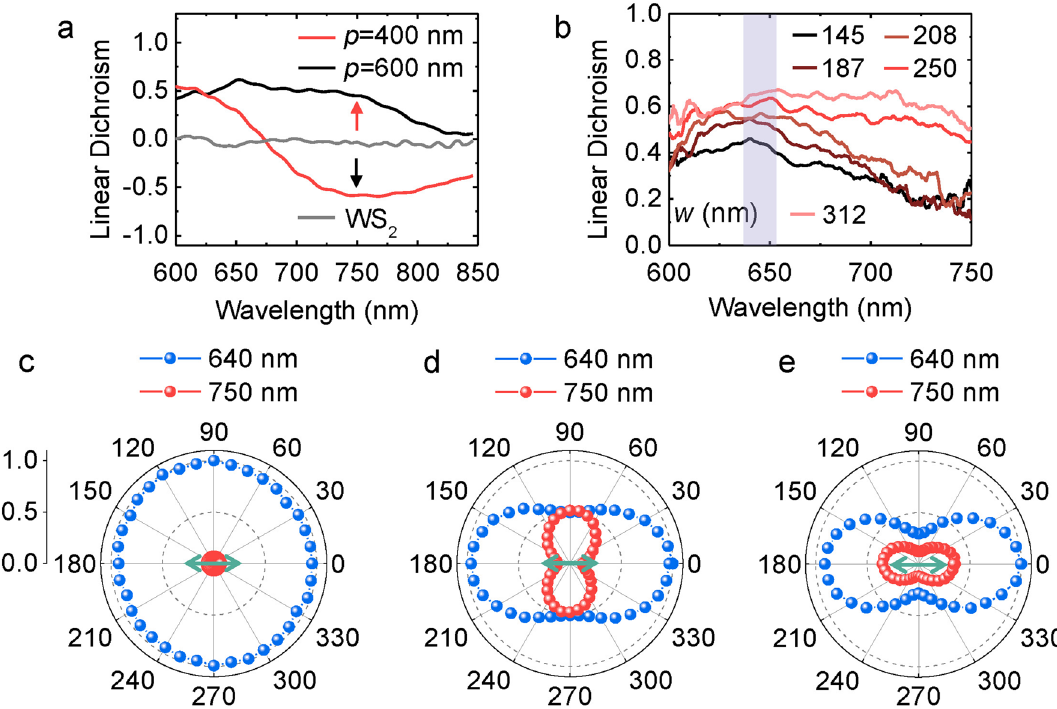
Figure 6. Linearity of the direct and indirect bandgap transitions modulated by the plasmonic nanowire array. ( a ) Linear dichroism of the PL emission for pristine bilayer WS 2 (grey curve) and WS 2 -Ag hybrid nanostructures with p = 400 (red curve) and 600 nm (black curve) respectively. ( b ) Linear dichroism of WS 2 -Ag hybrid nanostructure with p = 600 nm as a function of the wire width. ( c )–( e ) Normalized PL peak intensity as a function of the detection angle for pristine bilayer WS 2 ( c ) and hybrid nanostructures with p = 400 ( d ) and 600 nm ( e ), respectively. Blue/red dots indicate the emission of direct/indirect bandgap transitions, respectively. Here, zero corresponds to the center and 1.0 to the outermost dashed circle. Green arrows indicate the long axis of the